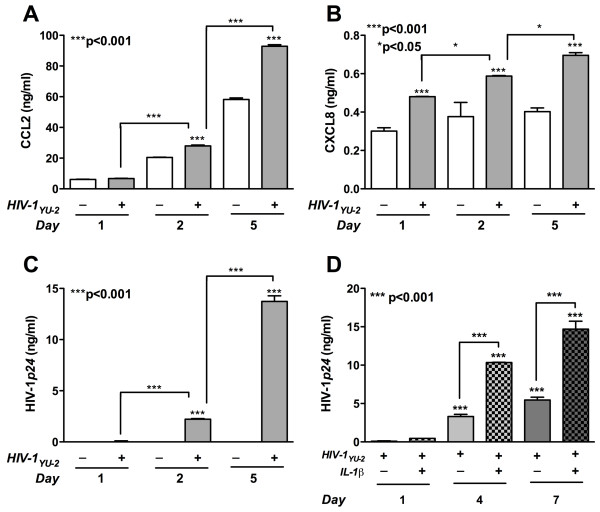
HIV-1YU-2-transfected astrocytes have enhanced levels of proinflammatory chemokines in a dose and time dependent manner. Following HIV-1YU-2-transfection, HIV-1p24, CCL2 and CXCL8 levels were assayed by ELISA. (A) HIV-1YU-2-transfection significantly increased culture supernatant cumulative CCL2 levels by 2 and 5 days as compared to both respective mock controls and day 1, HIV-1YU-2-transfected astrocytes (p < 0.001). (B) Astrocyte CXCL8 levels in the supernatants also increased significantly upon HIV-1YU-2-transfection as compared to mock controls (p < 0.001). CXCL8 levels in HIV-1YU-2-transfected astrocytes continued to increase significantly as compared to the previous day, over five days post-transfection (p < 0.05). (C) Cumulative HIV-1p24 levels in total cell extracts were assayed on 1, 2 and 5 days post-transfection to quantify viral protein expression. HIV-1YU-2-transfection significantly increased HIV-1p24 levels as compared to mock on day 2 and day 5 (p < 0.001). (D) In HIV-1YU-2-tranfected astrocytes treated with and without IL-1β a significant concomitant increase in HIV-1p24 expression was observed at both 4 and 7 days (p < 0.001).